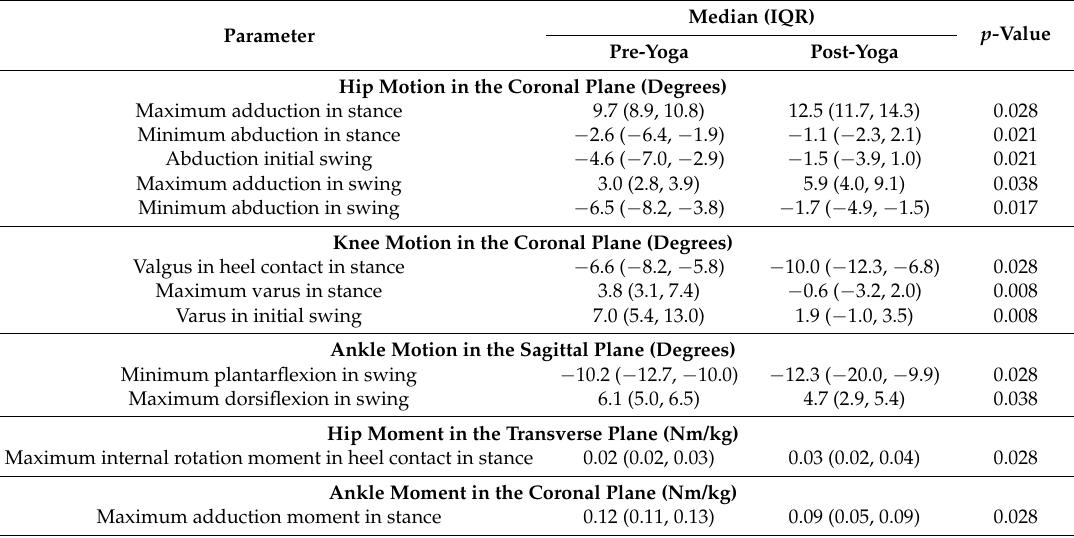
Table 2. Significant kinetic and kinematic differences of the lower extremities before and after yoga therapy ( n = 9, median (IQR), p < 0.05). Median (IQR) p- Value Parameter Pre-Yoga Post-Yoga Hip Motion in the Coronal Plane (Degrees) Maximum adduction in stance 9.7 (8.9, 10.8) 12.5 (11.7, 14.3) 0.028 Minimum abduction in stance − 2.6 ( − 6.4, − 1.9) − 1.1 ( − 2.3, 2.1) 0.021 Abduction initial swing − 4.6 ( − 7.0, − 2.9) − 1.5 ( − 3.9, 1.0) 0.021 Maximum adduction in swing 3.0 (2.8, 3.9) 5.9 (4.0, 9.1) 0.038 Minimum abduction in swing − 6.5 ( − 8.2, − 3.8) − 1.7 ( − 4.9, − 1.5) 0.017 Knee Motion in the Coronal Plane (Degrees) Valgus in heel contact in stance − 6.6 ( − 8.2, − 5.8) − 10.0 ( − 12.3, − 6.8) 0.028 Maximum varus in stance 3.8 (3.1, 7.4) − 0.6 ( − 3.2, 2.0) 7.0 (5.4, 13.0) 1.9 ( − 1.0, 3.5) 0.008 Ankle Motion in the Sagittal Plane (Degrees) Minimum plantarflexion in swing − 10.2 ( − 12.7, − 10.0) − 12.3 ( − 20.0, − 9.9) 0.038 Hip Moment in the Transverse Plane (Nm/kg) Maximum internal rotation moment in heel contact in stance 0.02 (0.02, 0.03) 0.03 (0.02, 0.04) 0.028 Ankle Moment in the Coronal Plane (Nm/kg) Maximum adduction moment in stance 0.12 (0.11, 0.13) 0.09 (0.05, 0.09) 0.028 IQR, interquartile